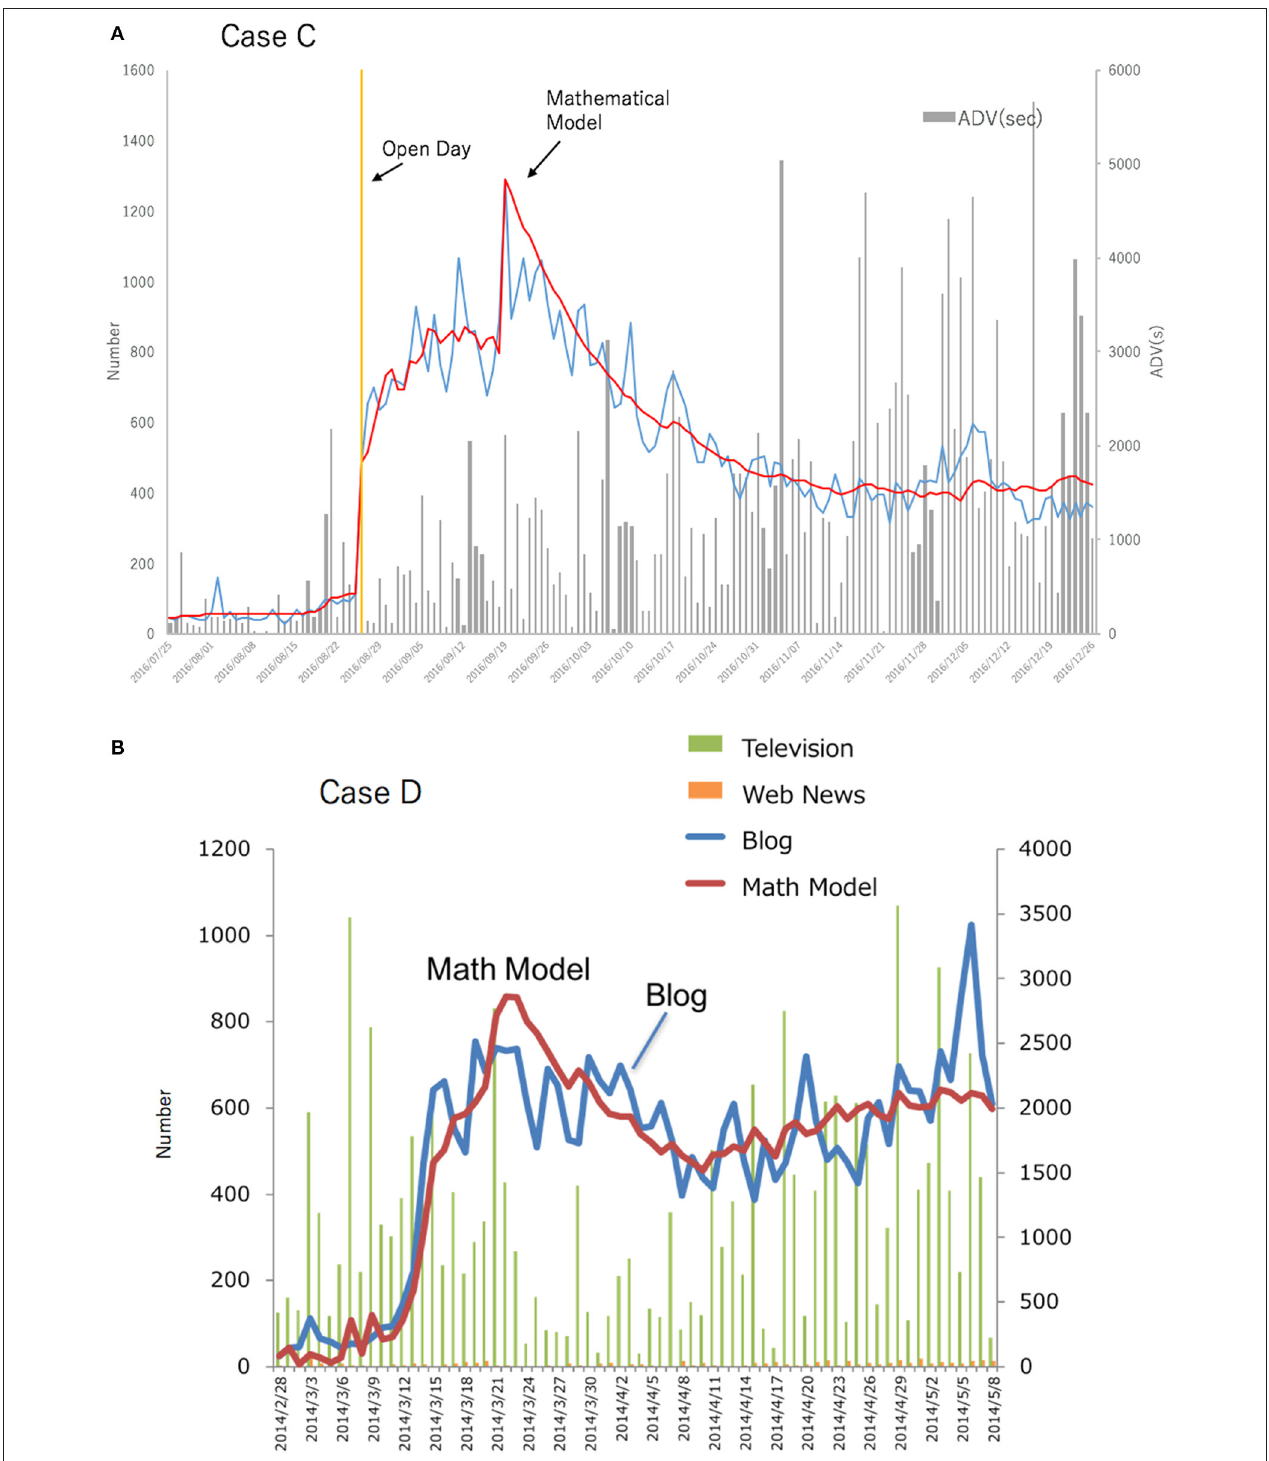
FIGURE 3 | Reputation of films (A) “Case C” and (B) “Case D” based on analysis using the mathematical model of the hit phenomenon. The line chart is the number of daily blog posts and the corresponding calculated values. The histogram (Case C) indicates [ADV (s)] is the number of daily exposures on TV information about “Case C” in seconds. And The histogram (Case D) indicates [ADV (s)] is the number of daily exposures on TV (Green) and the internet (Orange).